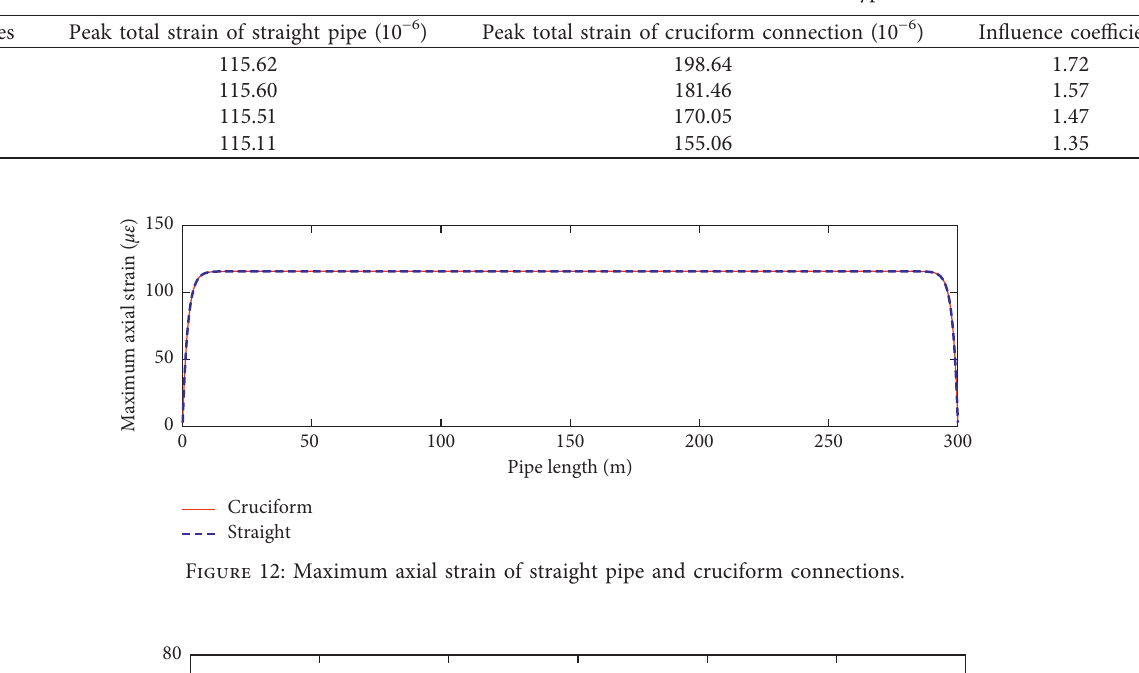
Table 5: Influence coefficients of cruciform connection in different site types.